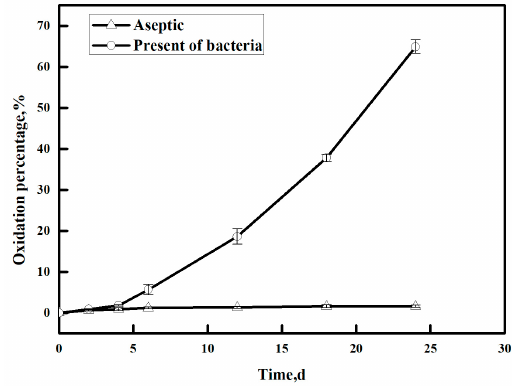
Figure 3. Trend in oxidation of pyrite with humic-acid layer.